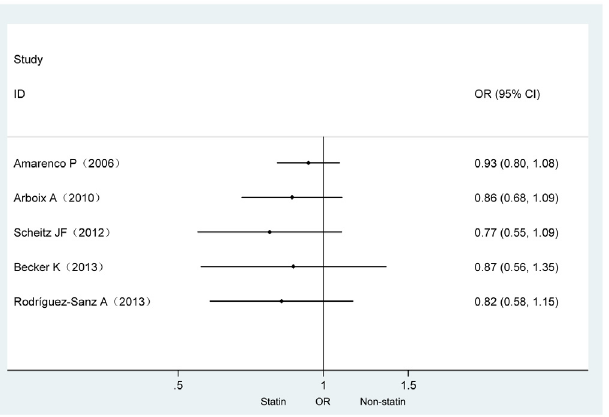
Fig 4. Cumulative meta-analysis of the effect of statins on infection after stroke or TIA(Note: weights are from random effects analysis).